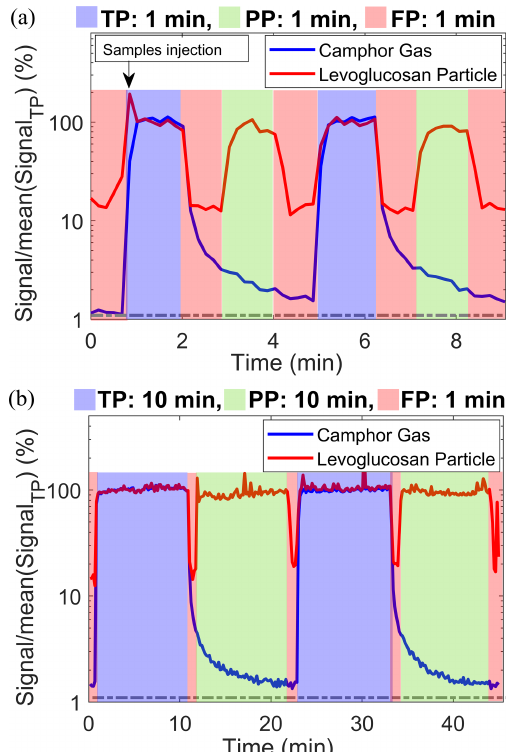
Figure 2. Dual-EESI measurements of gaseous camphor and par- ticulate levoglucosan for two different ratios of the background-to- sampling measurement period (a) 1 and (b) 0.1. Please note that the camphor in (b) was injected at the first minute as in (a) ; thus both sampling conditions have the same level of background (1%). The relative changes in the signals in percentage were obtained af- ter normalizing the signals by the averaged TP signal. Dashed gray lines denote the initial background level before the injection of cam- phor and levoglucosan. Different sampling time ratios (background to measurement time) are shown in Fig. S13 and Table S2. Data were collected at a time resolution of 1s and then averaged to 10s for